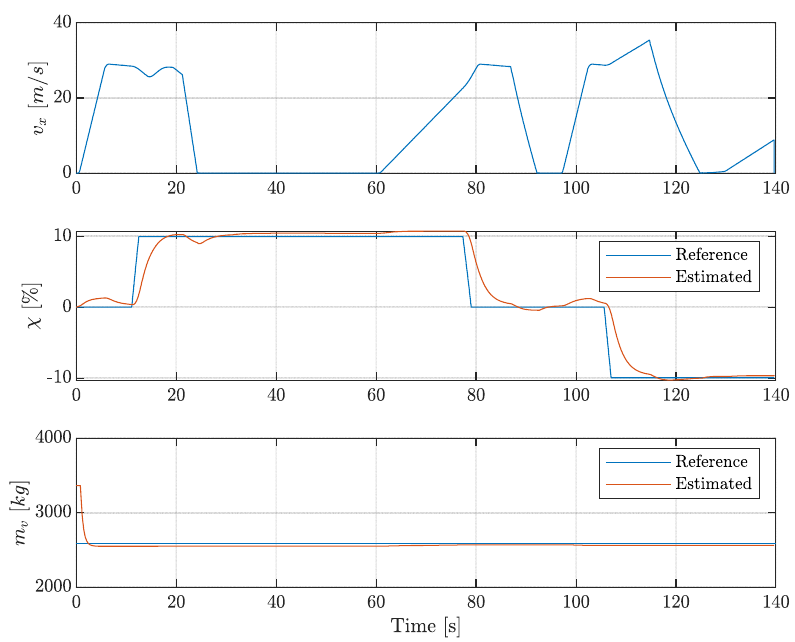
Figure A1. Results of the vehicle mass and road slope observer test run.